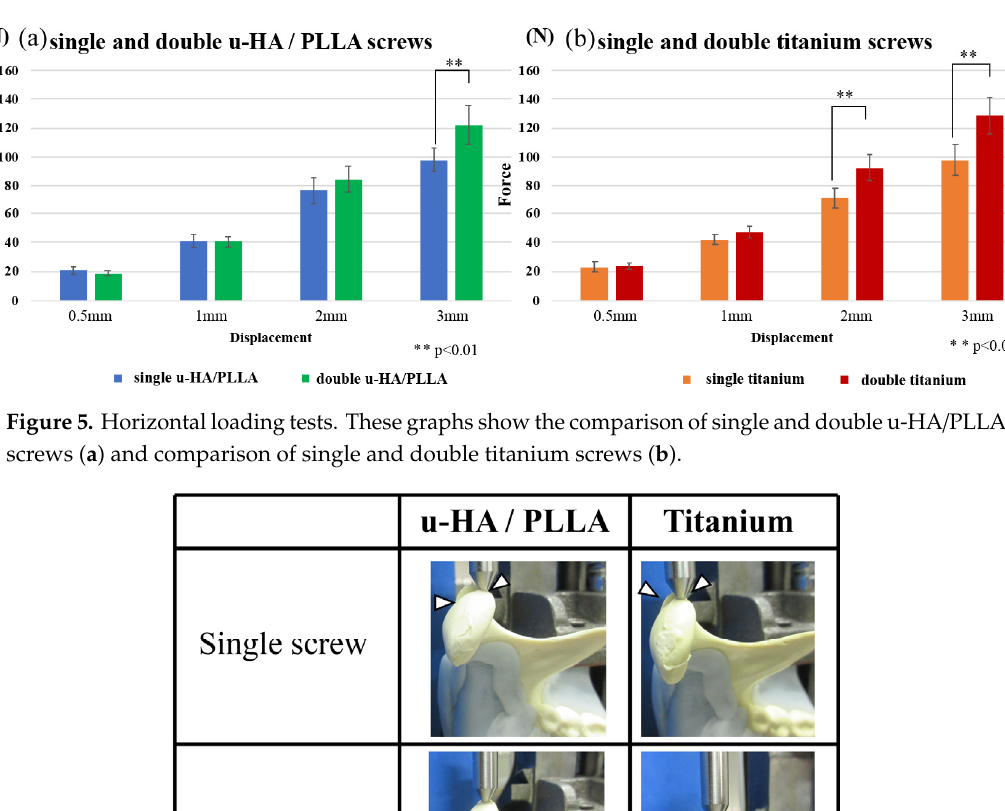
Figure 5. Horizontal loading tests. These graphs show the comparison of single and double u- HA/PLLA screws ( a ) and comparison of single and double titanium screws ( b ).